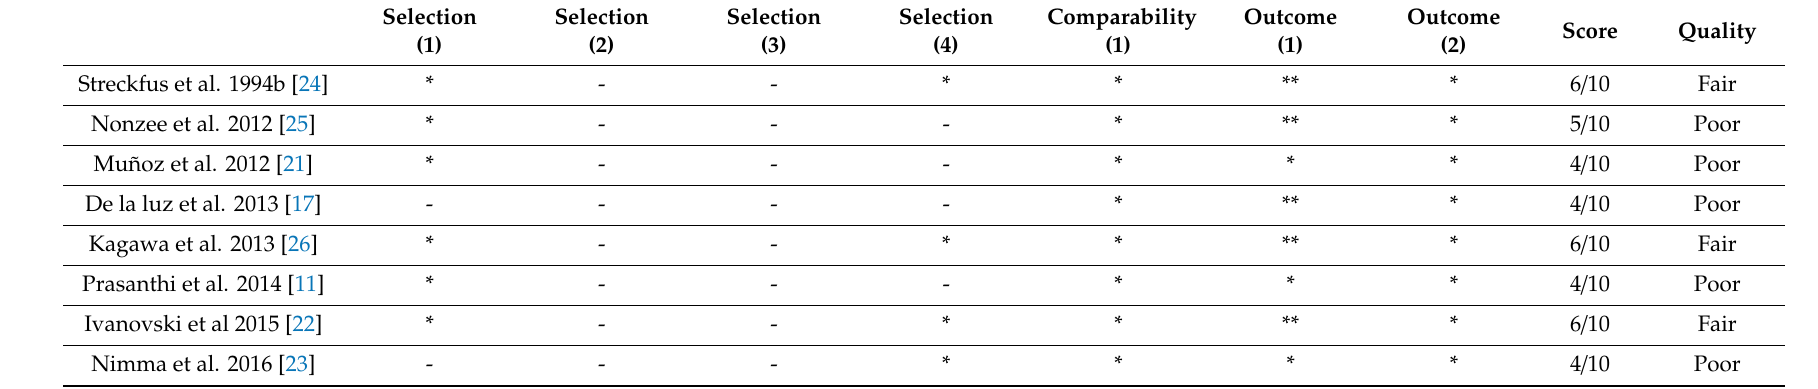
Table 3. The modified Newcastle–Ottawa scale for case-control